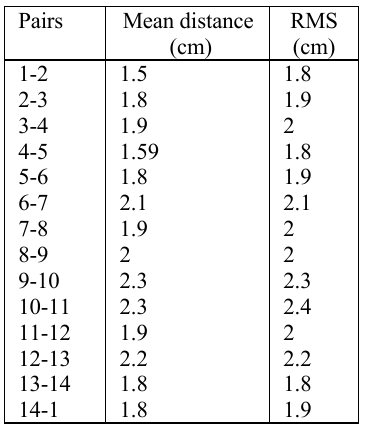
Table 6. point clouds of adjacent strips comparison.